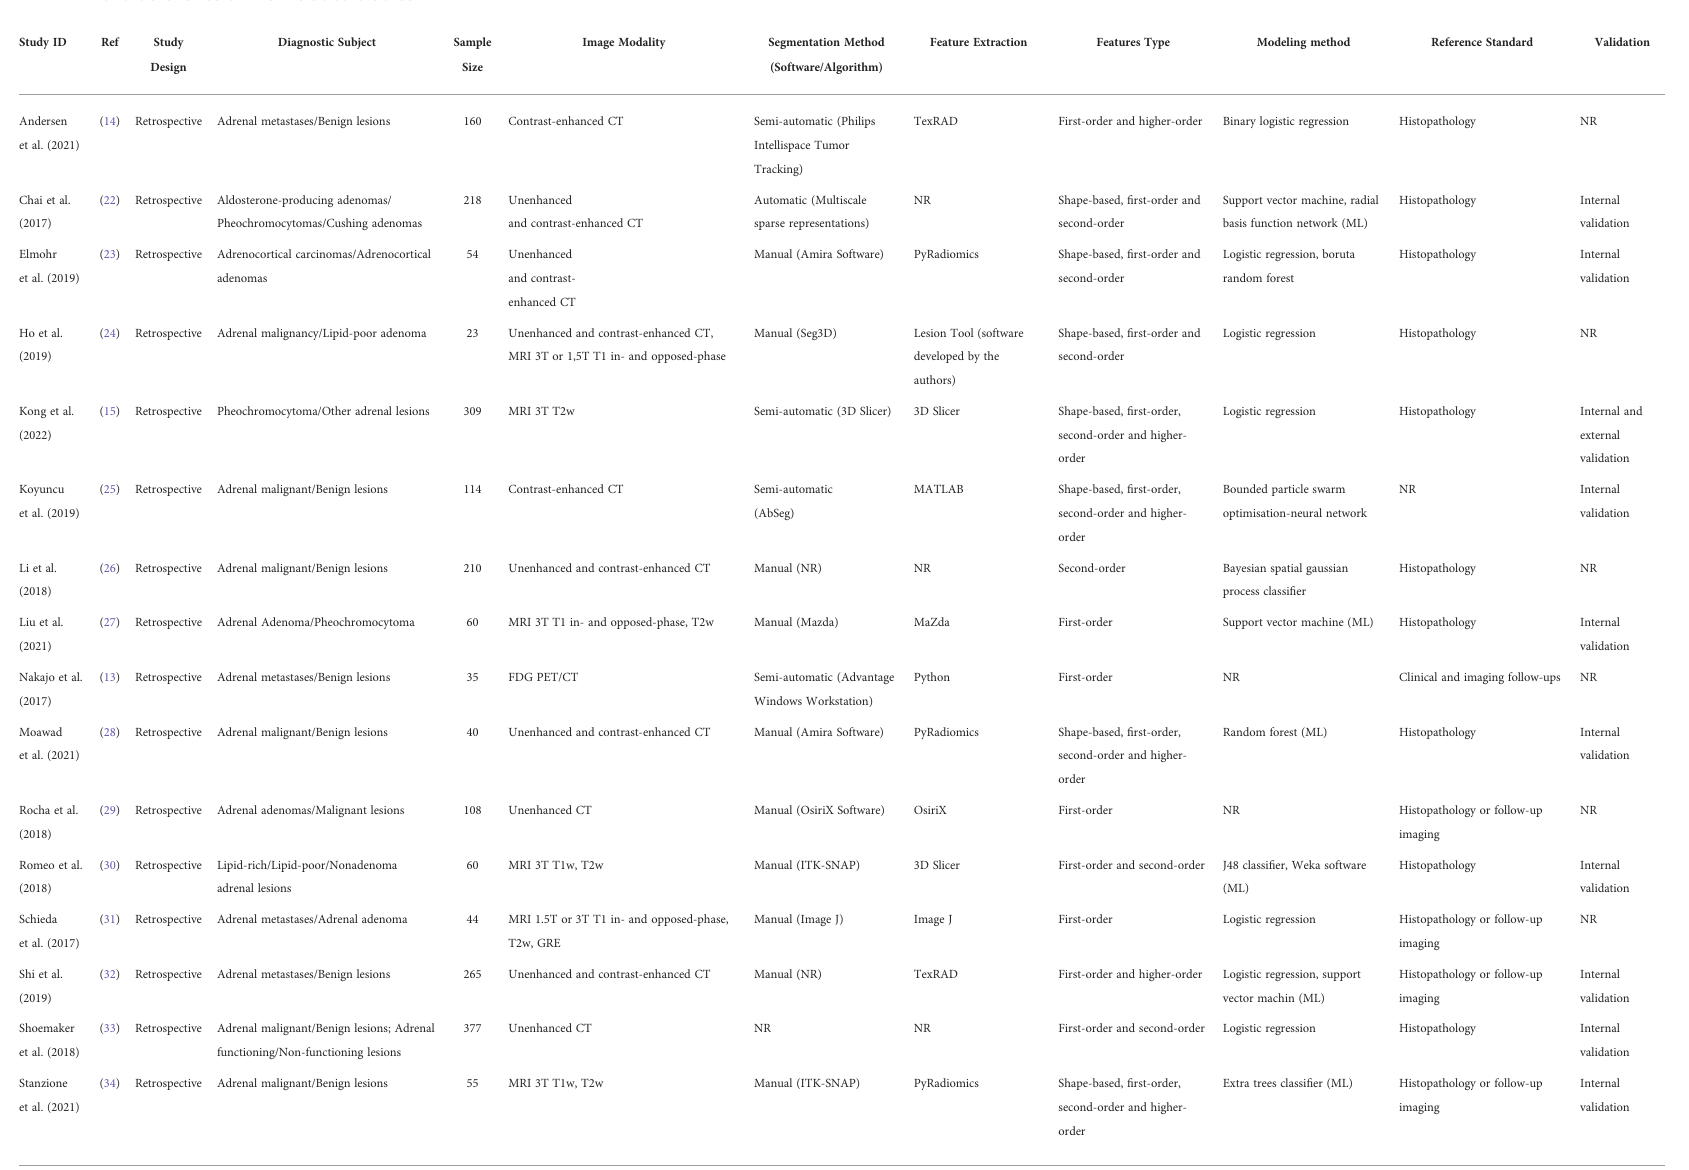
TABLE 1 Characteristics of the included